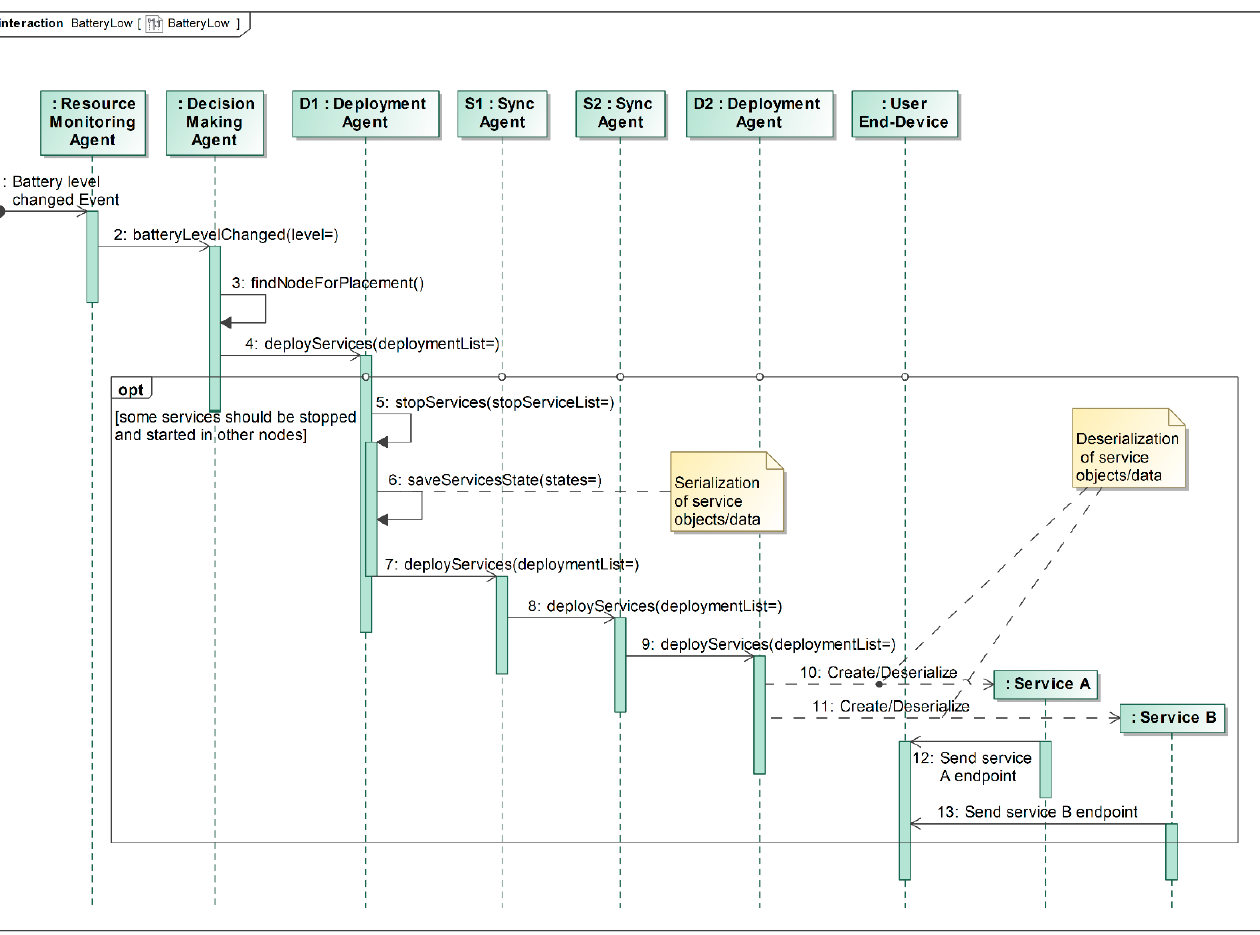
Figure 4 . Relocation of services in case of low computational resources. Figure 4. Relocation of services in case of low computational